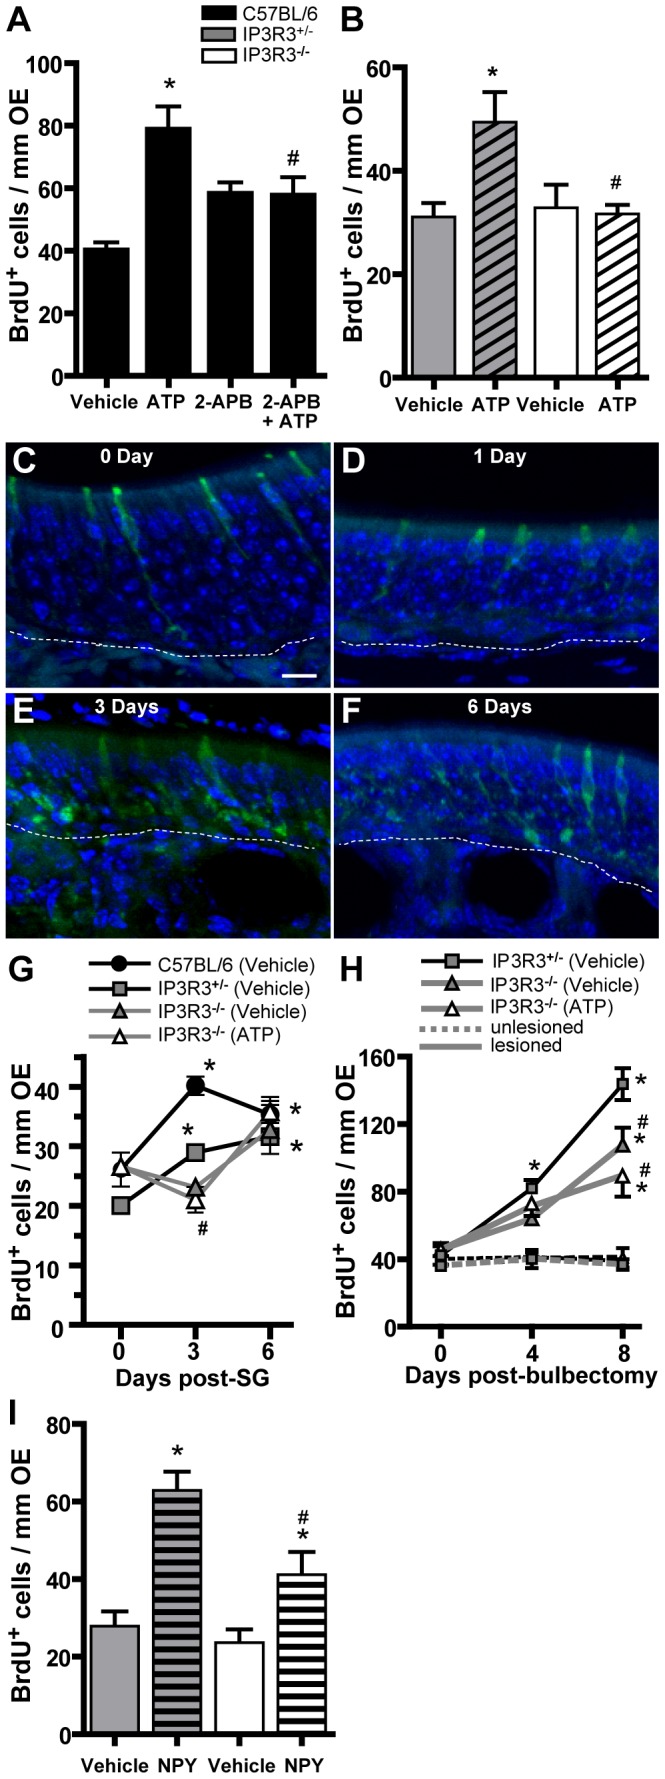
The response to injury is compromised in the OE of IP3R3−/− mice.(A–E) BrdU incorporation was quantified following treatments described below (mean +/− SD reported). (A) IP3 receptors mediate ATP-induced increase in cell proliferation. C57BL/6 mice intranasally aspired vehicle (saline) or the IP3 receptor inhibitor 2-APB (400 nmol/kg) 30 min prior to vehicle (saline) or ATP (400 nmol/kg). Tissue was collected 48 hours post-instillation of ATP. *, p<0.01 vs. vehicle, #p<0.05 vs. ATP (two-way ANOVA followed by Newman-Keuls post-hoc test; n = 9–12 sections from 3–4 mice.) Legend is for A, B, G–I. (B) ATP-induced increase in cell proliferation is abolished in the OE of IP3R3−/− mice. IP3R3+/− and IP3R3−/− mice intranasally aspired vehicle (saline) or ATP (400 nmol/kg) and tissue was collected 48 hours post-instillation of ATP. *, p<0.05 vs. vehicle in IP3R3+/−, #, p<0.05 vs. ATP in IP3R3+/− (two-way ANOVA followed by Newman-Keuls post-hoc test; n = 9–18 sections from 3–6 mice.) Refer to legend in (A). (C–F) IP3R3+/− cells do not degenerate following satratoxin G exposure. Representative confocal z-stack images of the OE with IP3R3-tauGFP expressing microvillous cells (green) and nuclei labeled with DAPI (blue) at 0, 1, 3 and 6 days following satratoxin G instillation (100 µg/kg) are shown. Scale bar, 20 µm. (G) C57BL/6, IP3R3+/− and IP3R3−/− mice intranasally aspired vehicle (saline) or satratoxin G (100 µg/kg) followed by daily aspiration of saline vehicle or ATP (400 nmol/kg) and tissue was collected 3 and 6 days post-administration of satratoxin G. Satratoxin G-induced increase in cell proliferation in the OE of IP3R3−/− mice is compromised and exogenous ATP does not increase proliferation. *, p<0.05 vs. day 0 of the respective group; #, p<0.05 vs. vehicle in C57BL/6 (two-way ANOVA followed by Tukey Kramer post-hoc test; n = 7–12 sections from 3–4 mice.) (H) Bulbectomy-induced increase in cell proliferation in the OE of IP3R3−/− mice is compromised and exogenous ATP does not increase proliferation. Unilateral bulbectomy was performed in IP3R3+/− and IP3R3−/− mice and tissue collected 4 and 8 days post-surgery. Tissue was collected at day 0 from sham-treated mice. Mice intranasally aspired vehicle (saline) or ATP (400 nmol/kg) for 3 or 7 days following surgery. Solid lines indicate lesioned side and dashed lines indicate unlesioned side. BrdU incorporation in the lesioned side was significantly higher than in the unlesioned side at 4 and 8 days in all groups (p<0.01, not indicated in figure). *, p<0.01 vs. day 0 of respective group; #, p<0.01 vs. lesion side of IP3R3+/− (two-way ANOVA followed by Tukey Kramer post-hoc test; n = 9–12 sections from 3–4 mice.) (I) Exogenous NPY significantly increases cell proliferation in the OE of IP3R3−/− mice. IP3R3+/− and IP3R3−/− mice intranasally aspired vehicle (saline) or NPY (4 nmol/kg) and tissue was collected 48 hours post-instillation of NPY. *, p<0.05 vs. respective vehicle; #, p<0.01 vs. NPY in IP3R3+/− mice (two-way ANOVA followed by Newman-Keuls post-hoc test; n = 9–12 sections from 3–4 mice.) Refer to legend in A.